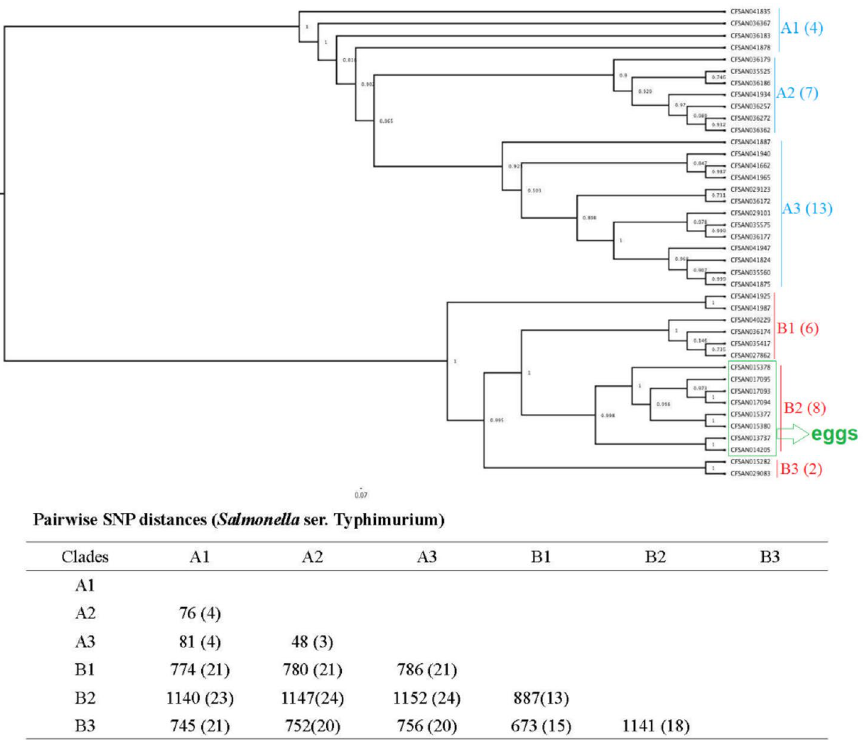
Figure 2. Phylogenetic tree of 40 Salmonella ser. Typhimurium isolates. Using core SNPs determined by FDA CFSAN SNP pipeline, the tree was constructed under the GTR-CAI model of FASTree 2. The analysis involved 673–1141 total SNP positions. Clades and subclades are indicated in colors ( A , blue; and B , red) with numbers of total isolates in each clade or subclade in parentheses. Isolates sourced from eggs and clustered in subclade B2 are highlighted in green, the rest were from chicken